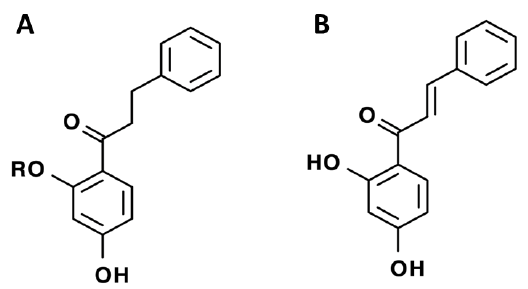
Figure 2. Structure of identified chalcones in C. album : ( A ) R = OH, 2′ , 4′ -dihydroxydihydrochalcone, R = OCH 3 , 2′ -methoxy- 4′ -hydroxydihydrochalcone; ( B ) 2′ , 4′ -dihydroxychalcone.